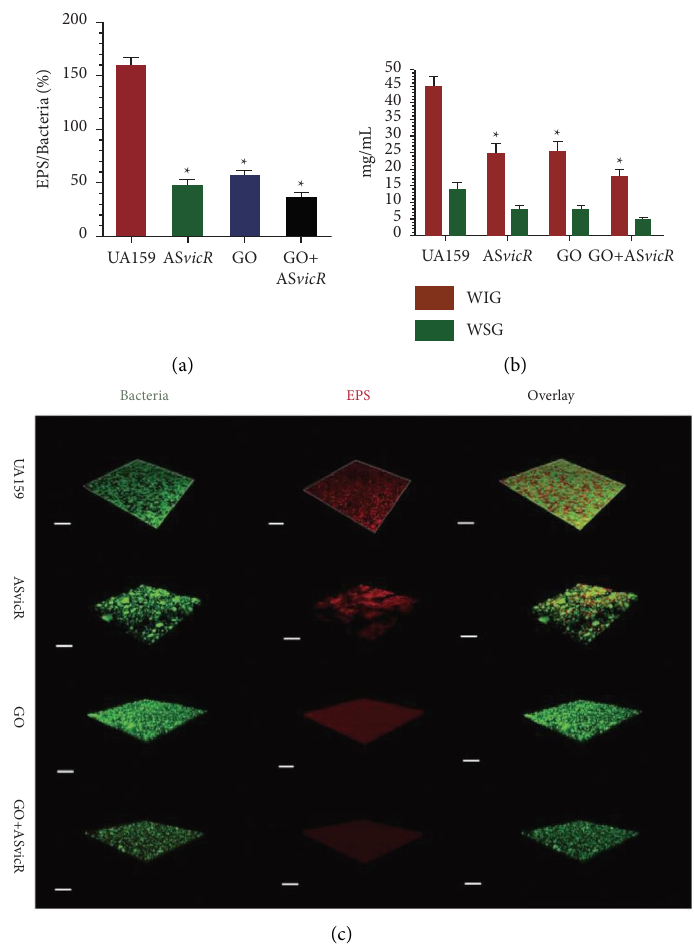
Figure 7: (a) Bar graph depicting the volume ratio of the exopolysaccharide (EPS) matrix to the bacterial biomass in the bioflms in diferent graphene complexes. (b) Bar graph depicting the water-insoluble glucan and water-soluble glucan levels of the diferent graphene complexes from diferent bacteria strains. (c) 3D reconstruction of the bioflms in diferent graphene complexes where green displays bacteria and red displays the EPS matrix (reprinted with permission from [83]) (Copyright 2020, American Chemical